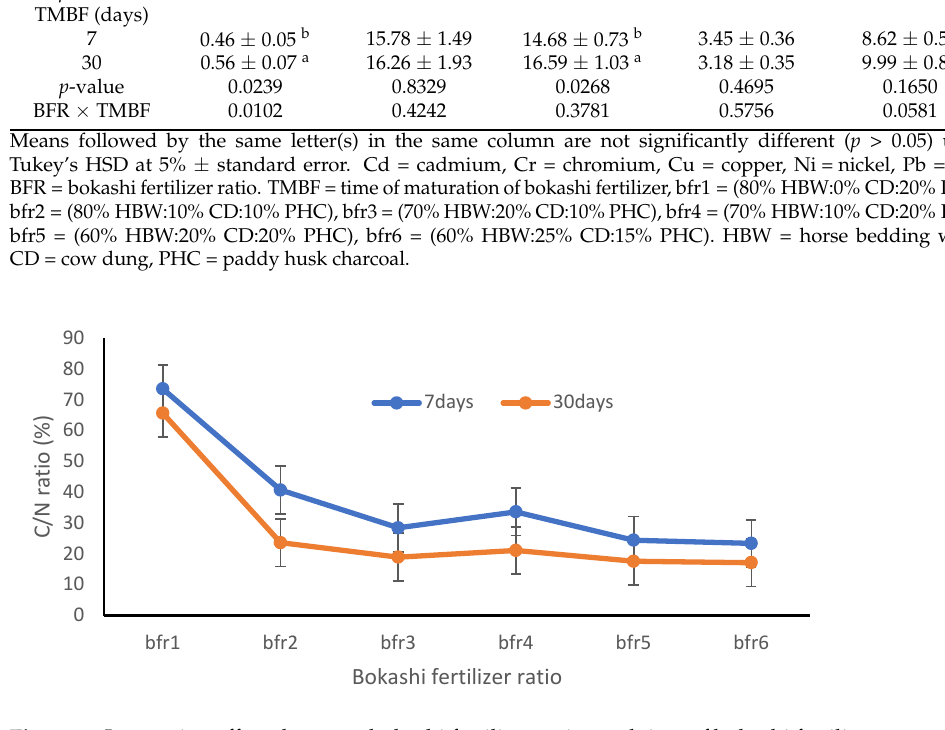
Figure 5. Interaction effects between bokashi fertilizer ratios and time of bokashi fertilizer maturation (days) on the C/N ratio. Bfr1 = (80% HBW:0% CD:20% PHC), bfr2 = (80% HBW:10% CD:10% PHC), bfr3 = (70% HBW:20% CD:10% PHC), bfr4 = (70% HBW:10% CD:20% PHC), bfr5 = (60% HBW:20% CD:20% PHC), bfr6 = (60% HBW:25% CD:15% PHC). HBW = horse bedding waste, CD = cow dung, PHC = paddy husk charcoal.